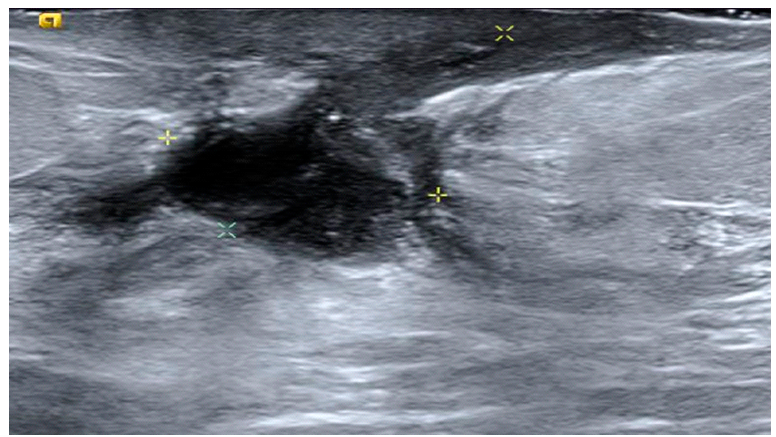
Figure 6. Example of an ovoid MF on ultrasound that was referred for surgery.